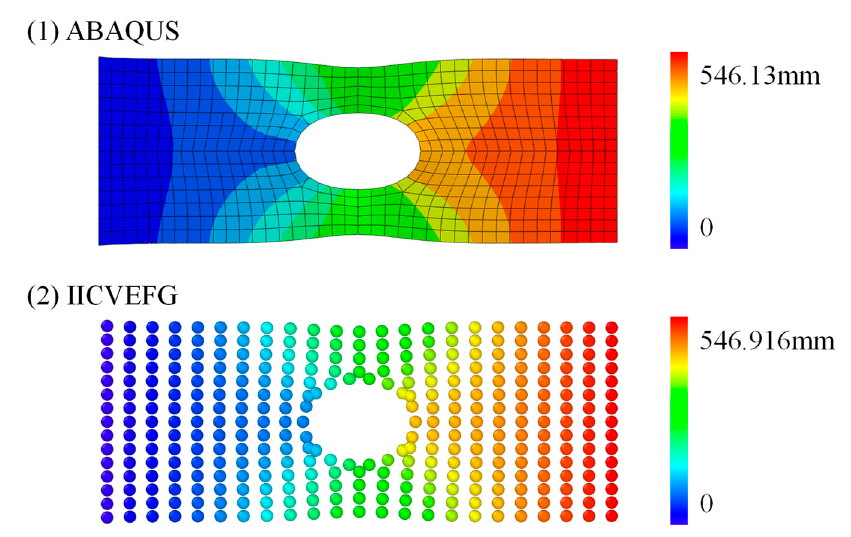
Figure 15. The displacement distributions. For this example, the relation of the traction and the displacement u 1 at point ( 5, 0 ) is also discussed in Figure 16. Around the value p = 100 N/m the plastic deformation occurs; and around p = 300 N/m the deformation of the whole structure is plastic deformation.